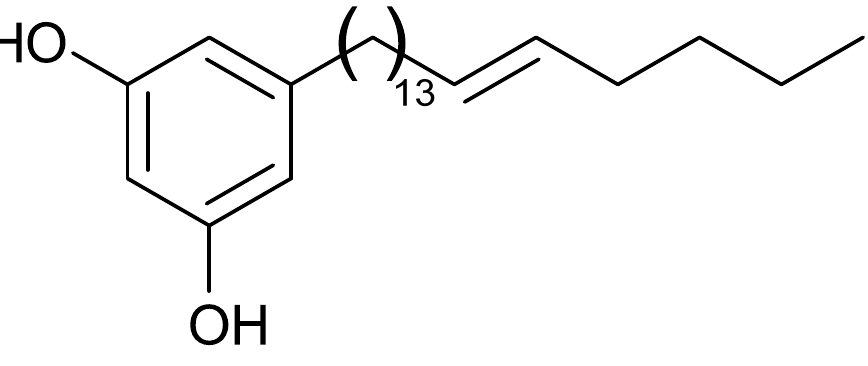
Figure 9. Structure of MP-1.